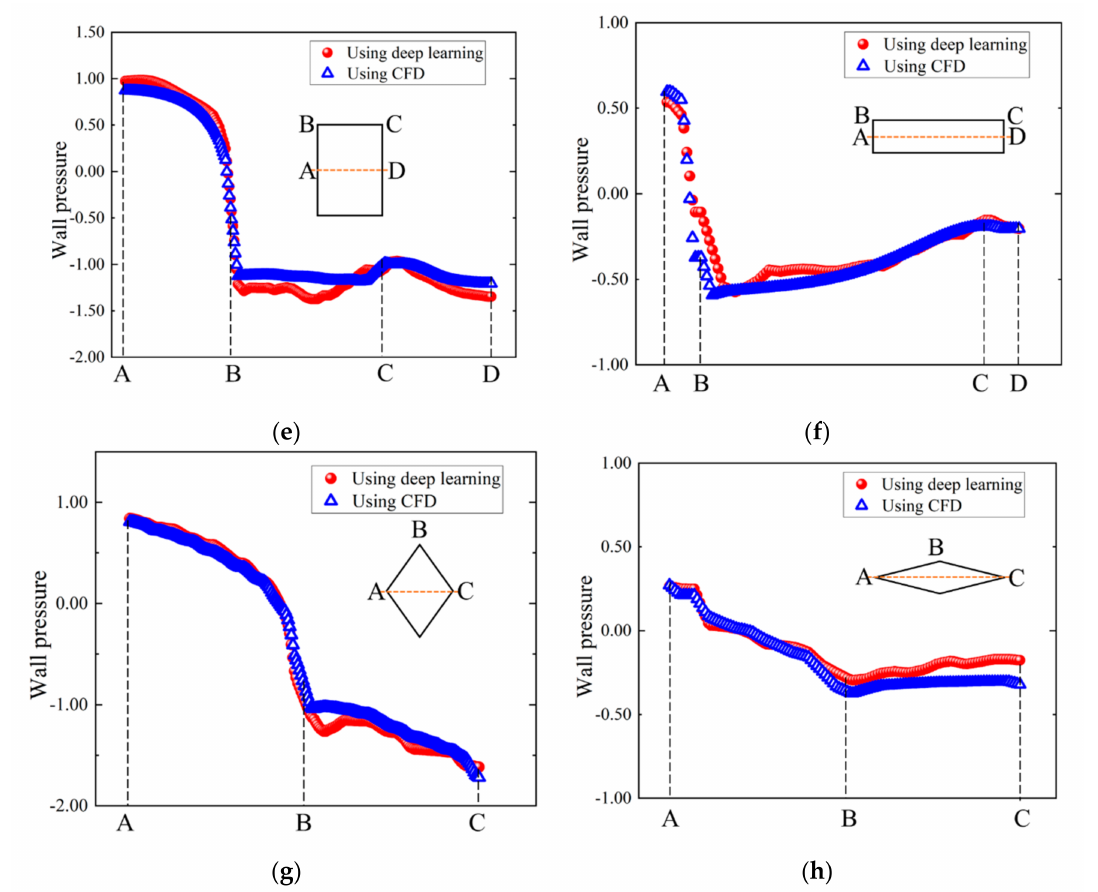
Figure 11. Comparison of the prediction effects of the wall pressure field of the four shapes. ( a ) The ellipse with AR = 0.71. ( b ) The ellipse with AR = 4. ( c ) The hexagon with AR = 0.56 R = 0.3. ( d ) The hexagon with AR = 7 R = 0.1. ( e ) The rectangle with AR = 0.71. ( f ) The rectangle with AR = 4. ( g ) The diamond with AR = 0.71. ( h ) The diamond with AR =